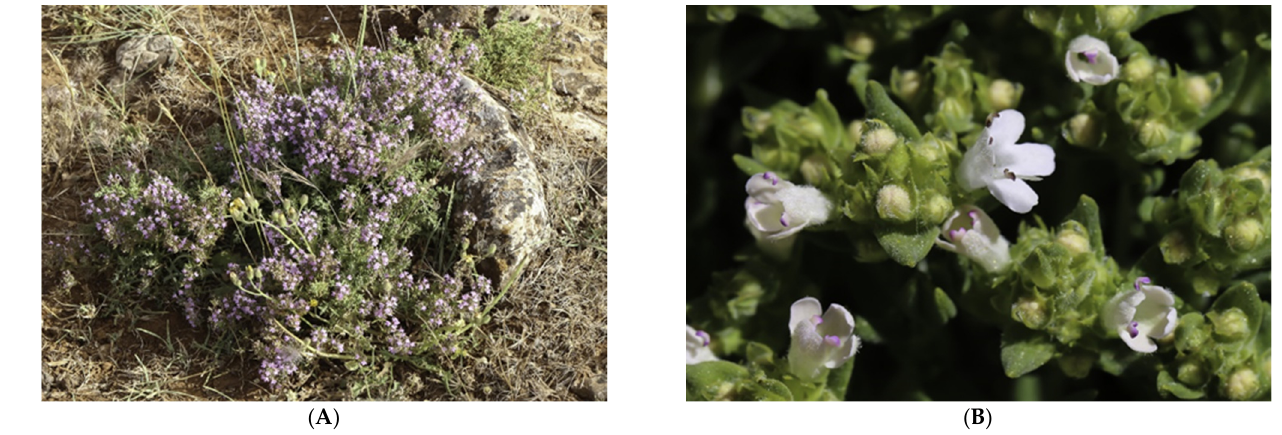
Figure 6. ( A ) Thymus zygis L. and ( B ) Thymus willdenowii